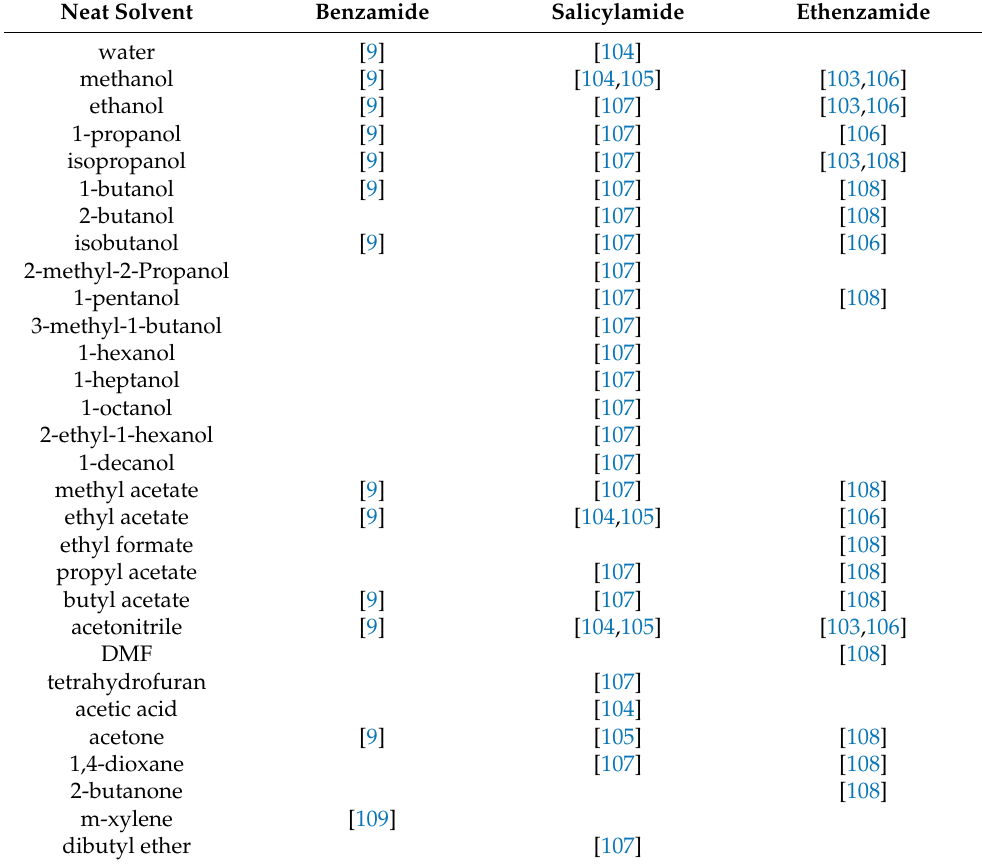
Table 1. List of neat solvents for which experimental solubility of studied aromatic amides were experimentally